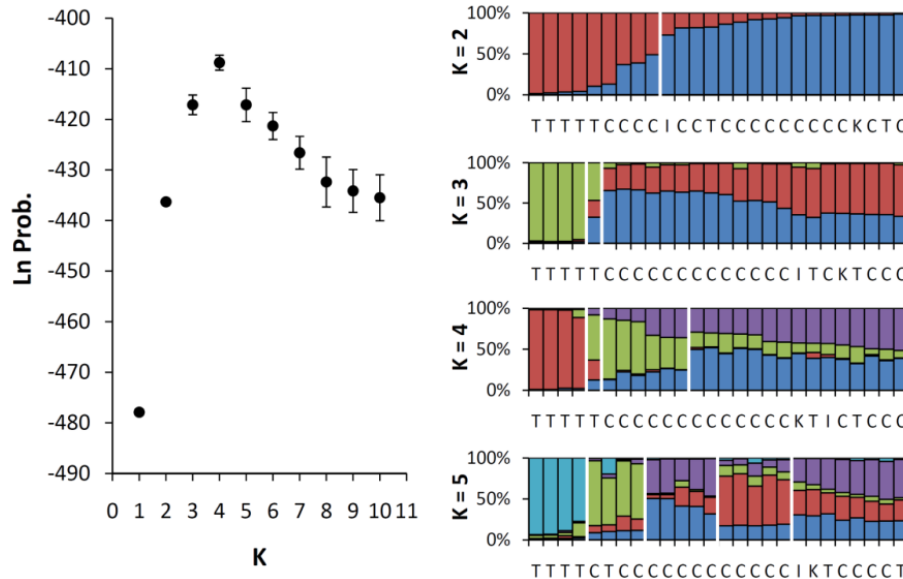
Figure 4. Genetic subdivision inferred using the Bayesian-clustering method implemented in the STRUCTURE program [31] for eight neutral microsatellite loci. The left plot is the log of the estimated posterior probability of K , which indicates a best fit of K = 4; the right panels are individual genotypes grouped by K = 2~5; the marks C, T, I, and K of each individual plot indicate the cultivar samples, the wild samples of Taiwan, India, and Korea,